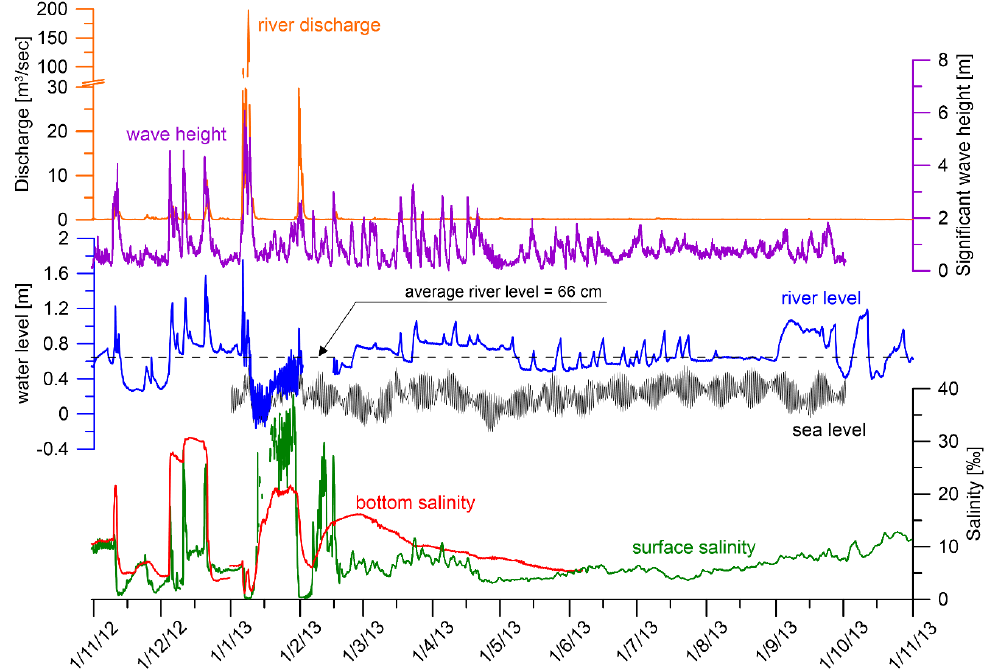
Figure 2. Alexander River discharge, level, and salinity (surface and bottom water, 250 and 500 m, respectively, from the sea). Resolution was at 1 h. Also shown are the sea level from the Hadera Meteomarine Monitoring GLOSS station 80 and the shelf wave height (data from the Israel Oceanography and Limnological Research, IOLR).